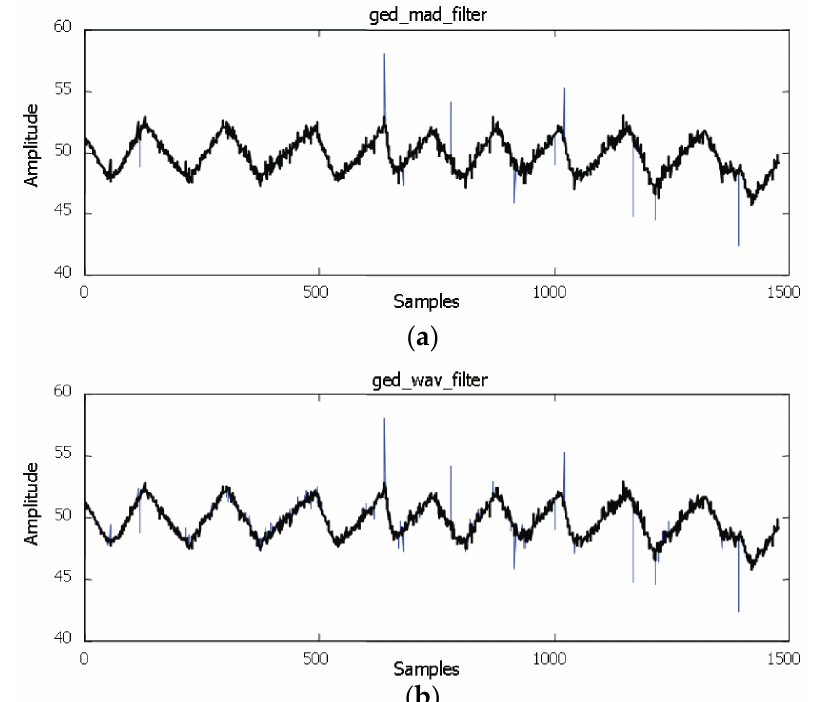
Figure 9. Comparison between ( a ) the presented algorithm in [10] and ( b ) that wavelet based on [5] proposed here.